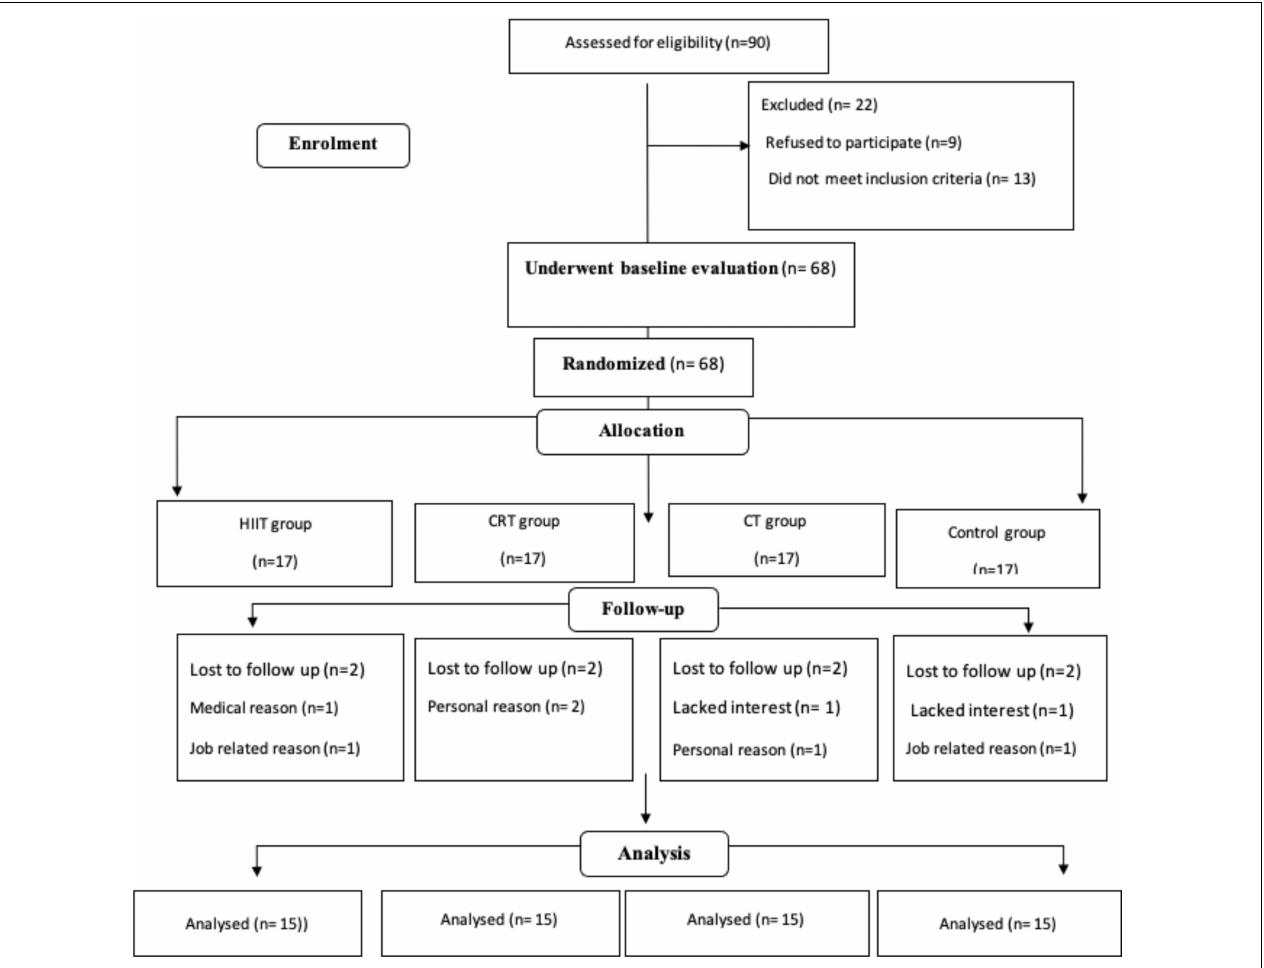
FIGURE 1 | Participant selection flow chart. MICT, Moderate Intensity Continuous Training; CRT, Circuit Resistance Training; and HIIT, High Intensity Interval